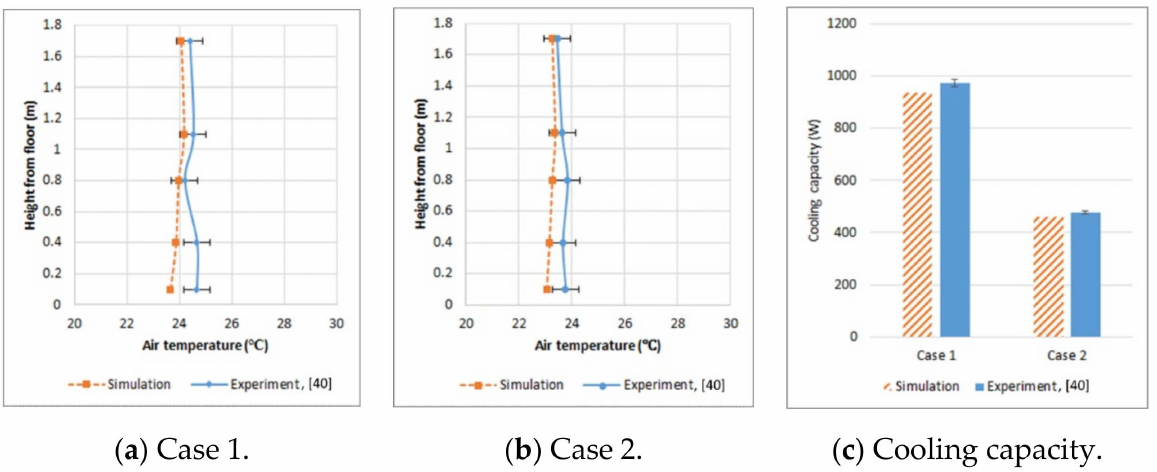
Figure 6. Comparison of simulated and experimental results for air temperature and cooling